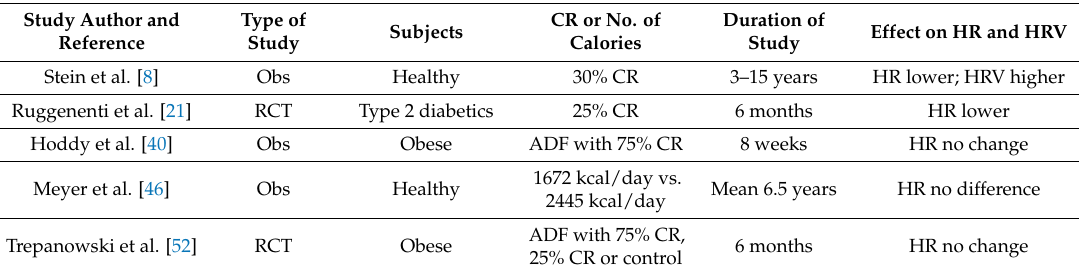
Table 2. Summary of studies showing the effect of fasting or caloric restriction on lowering heart rate in >20 human